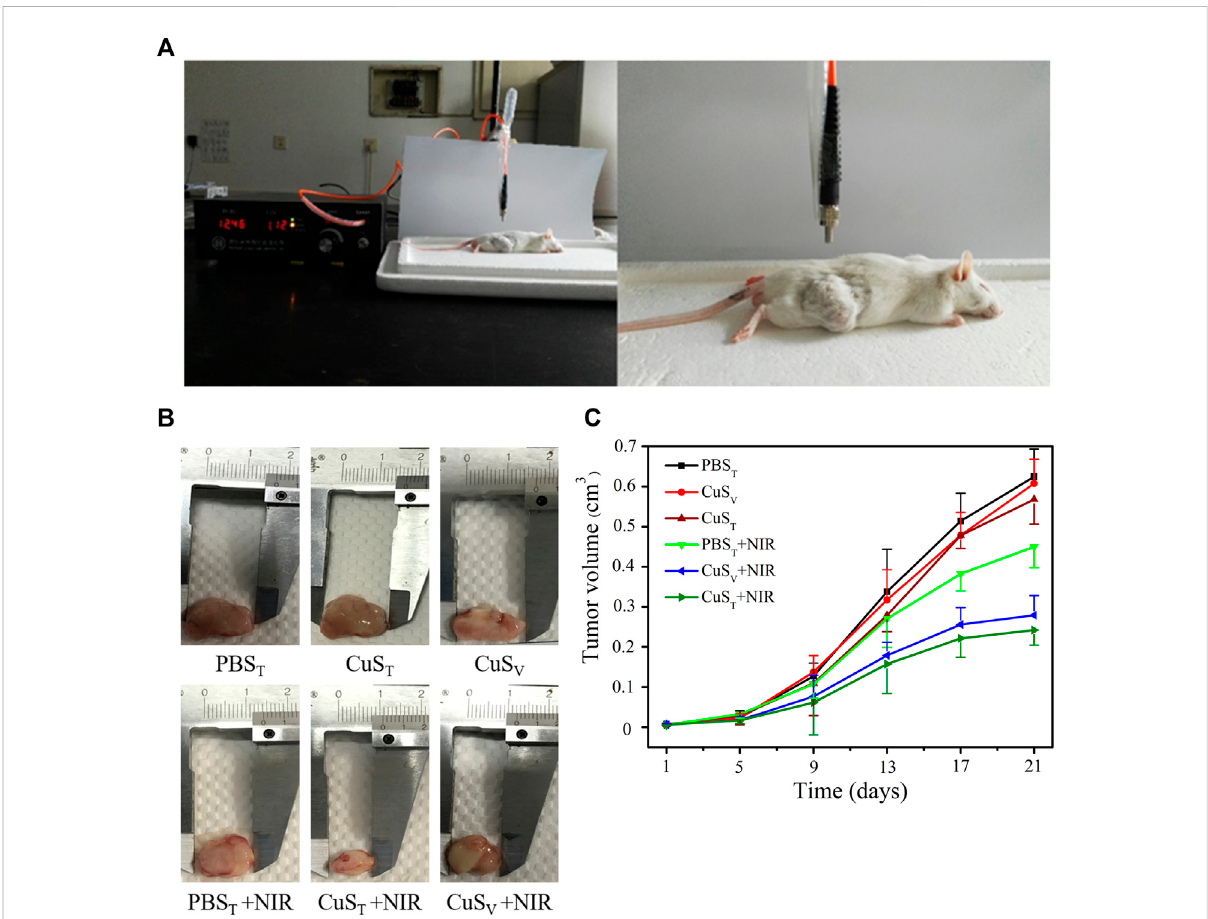
FIGURE 5 Effects of photothermal therapy ontumorgrowth inH22 hepatoma-bearingmice. H22 cells wereinjected subcutaneouslyinto theback ofthe right hind limb of male Kunming mice aged 6 weeks. Mice were randomly divided into six groups after tumor formation according to tumor volume. PBS T group, intratumoral injection of PBS solution; PBS T + NIR group, intratumoral injection of PBS solution and irradiation with 980 nm near- infrared light (2.0 W/cm 2 ); CuS T group, intratumoral injection of CuS-BSA NPs solution; CuS T + NIR group, intratumoral injection of CuS-BSA NPs solution and irradiation with 980 nm near-infrared light (2.0 W/cm 2 ); CuS V group, caudal vein injection of CuS-BSA NPs solution; CuS V + NIR group, intratumoral injection of CuS-BSA NPs solution and irradiation with 980 nm near-infrared light (2.0 W/cm 2 ). The concentration of CuS-BSA NPs diluted in PBS was 100 μ g/mL, and the dose was 600 μ g/kg. PBS solution was injected at a dose of 6 mL/kg. Photothermal treatment was performed once a week for a total of 3. (A) Photothermal treatment of H22 tumor-bearing mice with a near-infrared heating device.